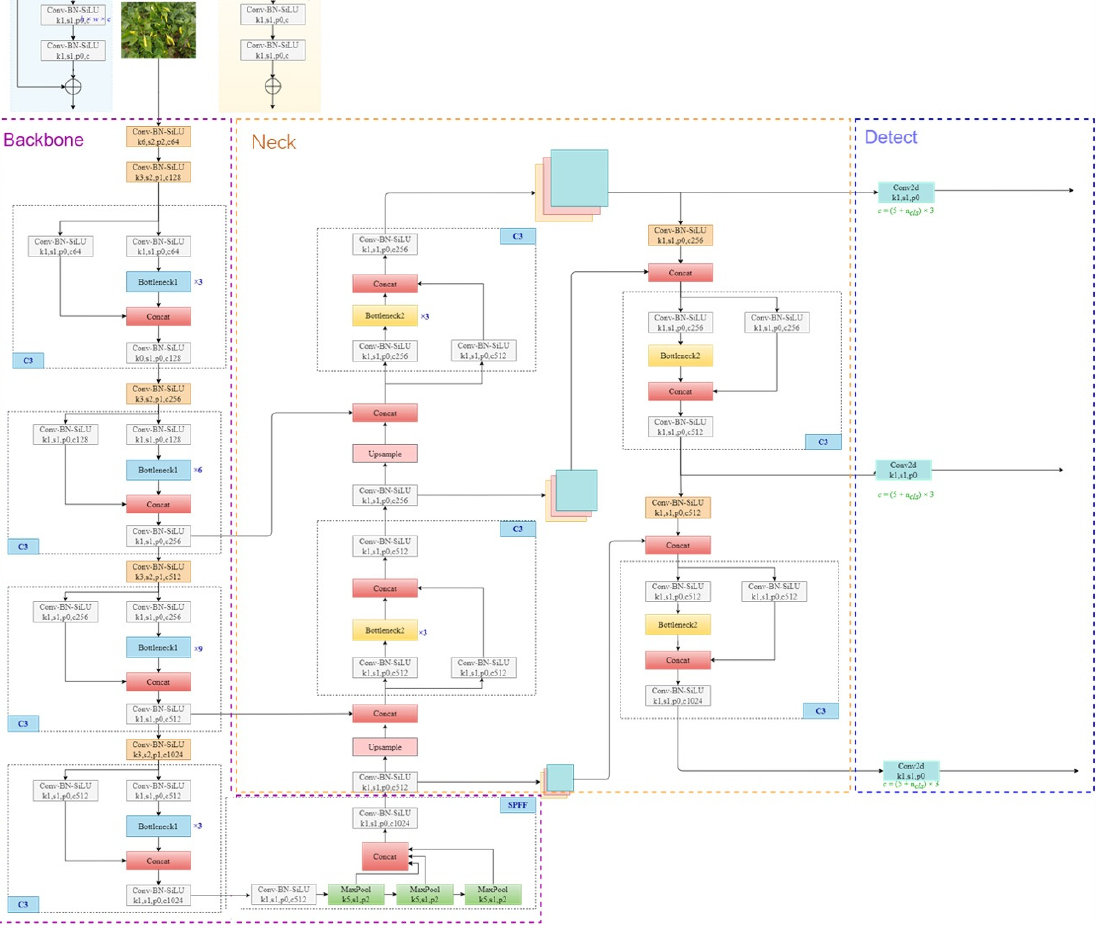
Figure 4. Framework of YOLOv5s.